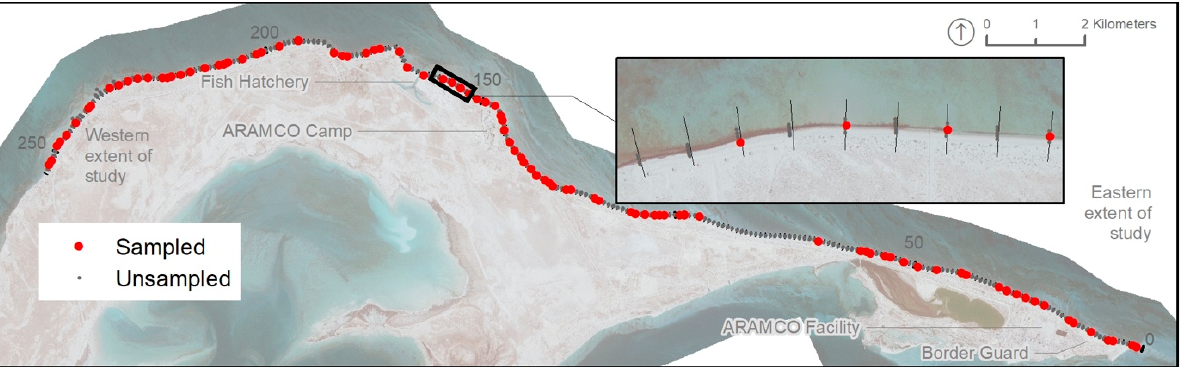
Figure 4. Locations of the Abu Ali Island sediment samples that were analyzed for TPH and biomarkers.